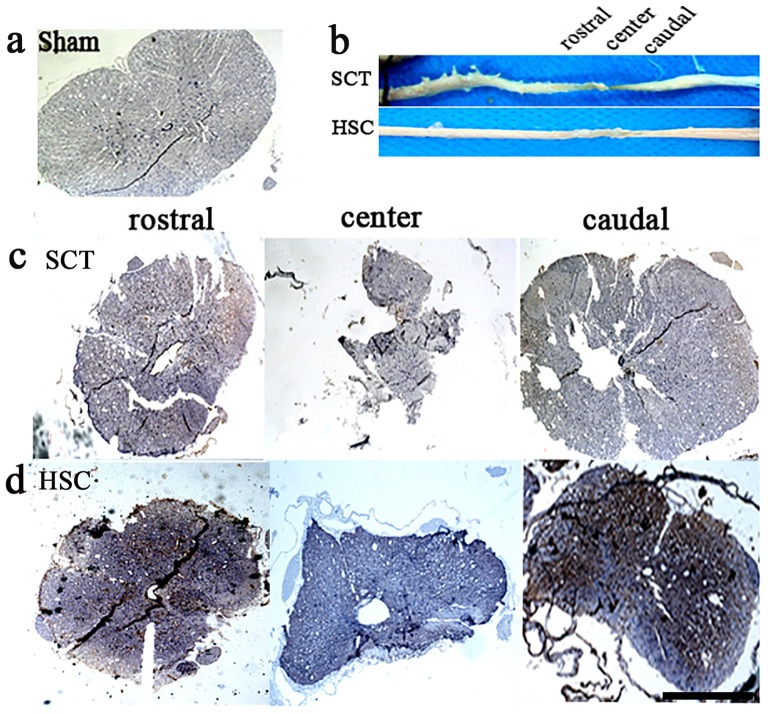
HSC transplantation restored the volume of spared spinal cord. After SCT, compared with the sham one (A), both rostral and caudal spinal cord exhibited a narrow shape, structure was damaged. Moreover, the volume in injured center decreased apparently with the narrowest shape (B) upper, (C). Comparatively, HSC transplantation resulted in a significant increase on the volume of spared spinal cord (B) down, (D). Bar = 200 μm.